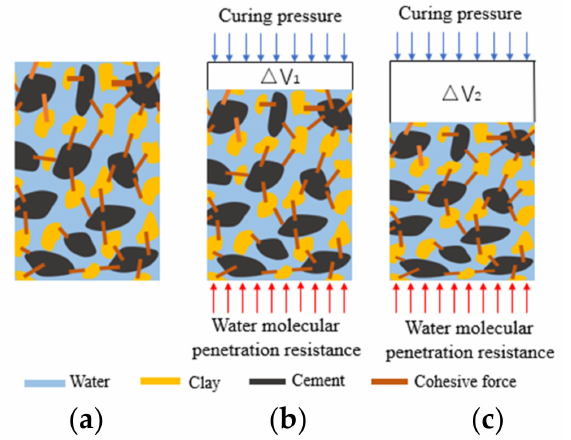
Figure 10. Influencing mechanism of curing pressure on strength of clay-cement slurry: ( a ) 2 MPa; ( b ) 4 MPa; ( c ) 8